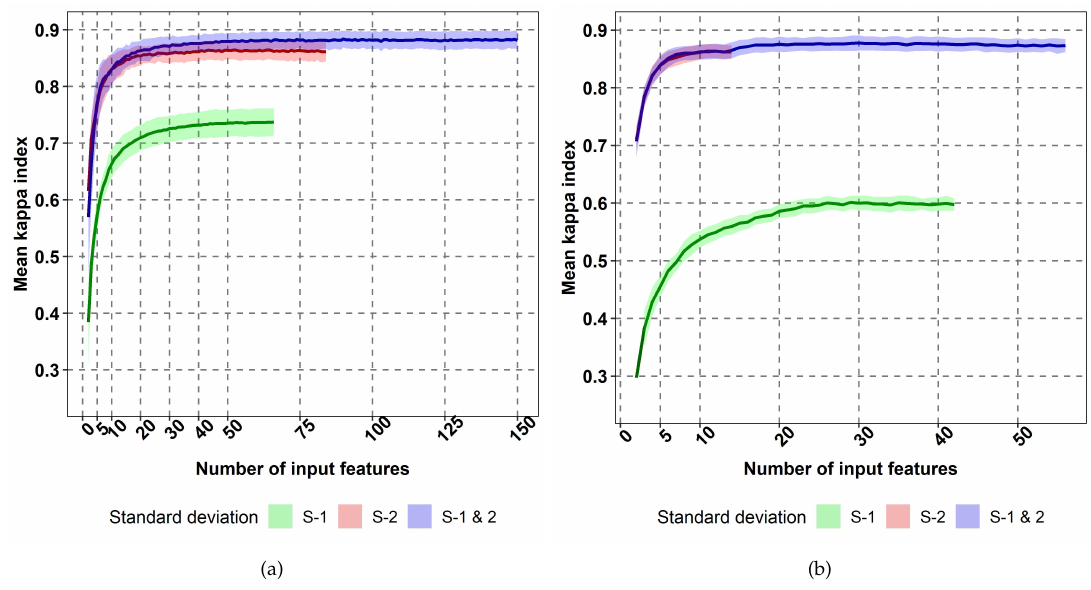
Figure 3. Mean kappa index of the incremental classifications for Sentinel-1 data alone (green), Sentinel-2 data alone (red), and combined Sentinel-1 & 2 data (blue) as a function of the number of input features for ( a ) the Spanish study area and ( b ) the Brazilian study